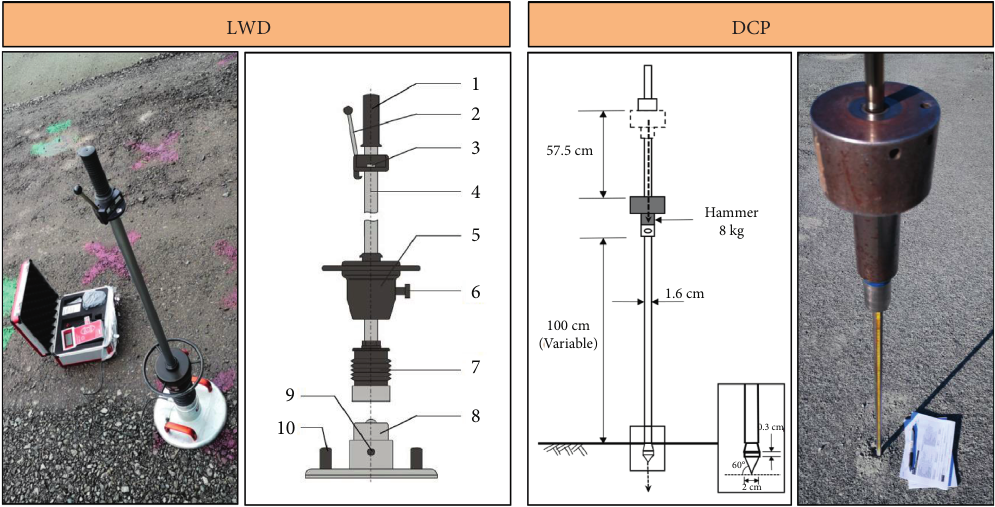
Figure 6: Components of the LWD and DCP used in the field test [56, 57].